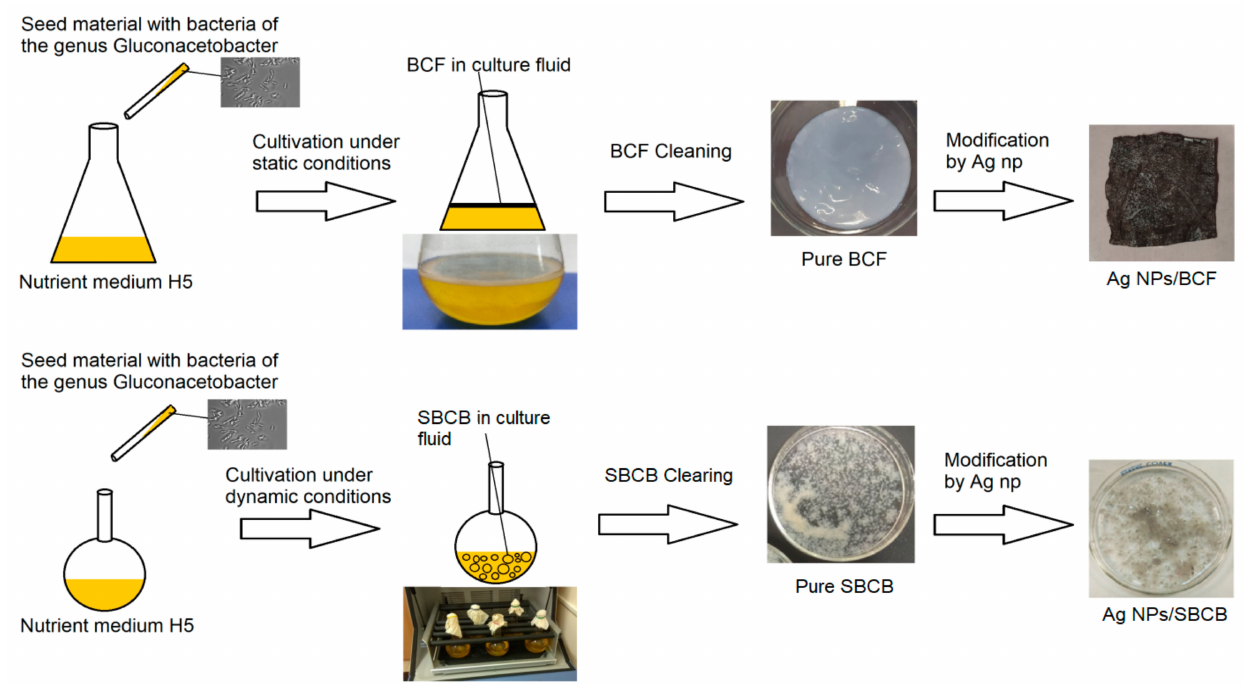
Figure 1. Scheme for obtaining BCF and SBCB with Ag nanoparticles.